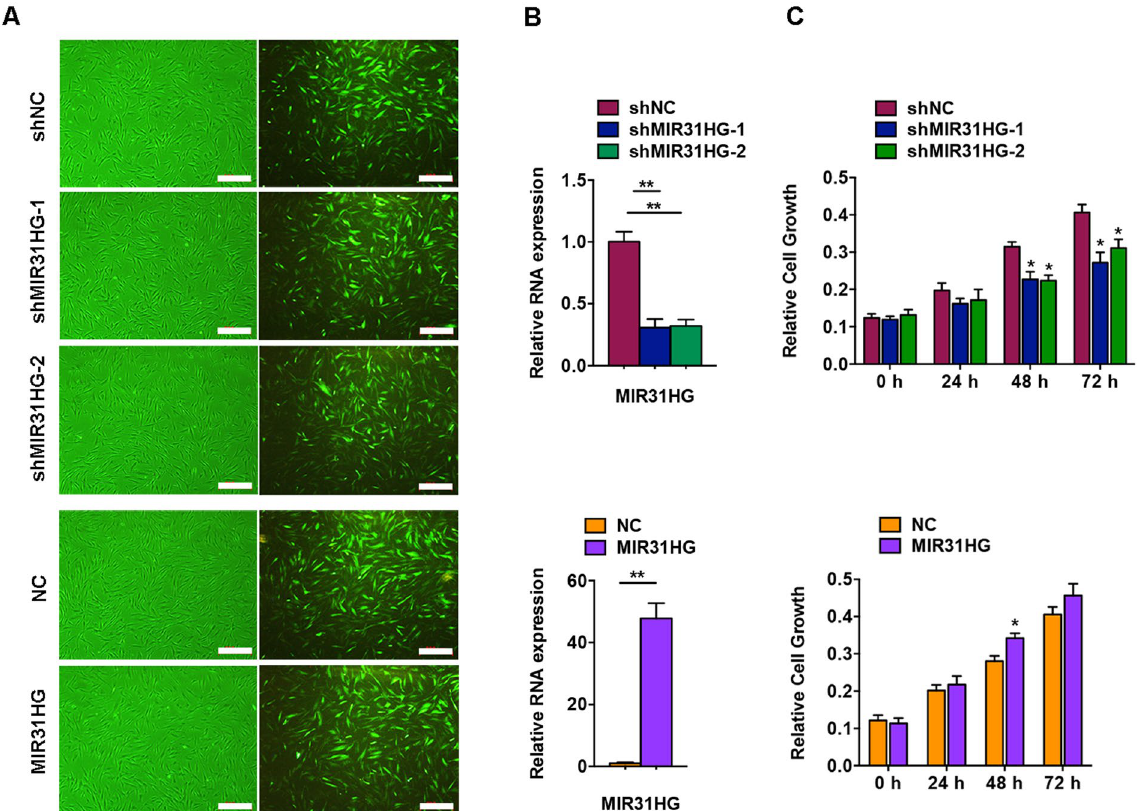
Figure 3. MIR31HG promoted cell proliferation of hASCs. ( A ) The hASCs were transfected with lentivirus expressing sh MIR31HG-1 , sh MIR31HG-2 , the scrambled nontargeting vector (shNC), MIR31HG , or the scrambled vector (NC). Fluorescent photomicrographs show the efficiency of lentivirus transduction ( > 90%). Scale bar, 500 μ m. ( B ) Relative expression of MIR31HG in the sh MIR31HG groups (up) or the MIR31HG group (down). ( C ) CCK-8 assay showing cell proliferation in the sh MIR31HG groups (up) or the MIR31HG group (down). Results are presented as mean ± SD ( * P < 0.05, ** P <